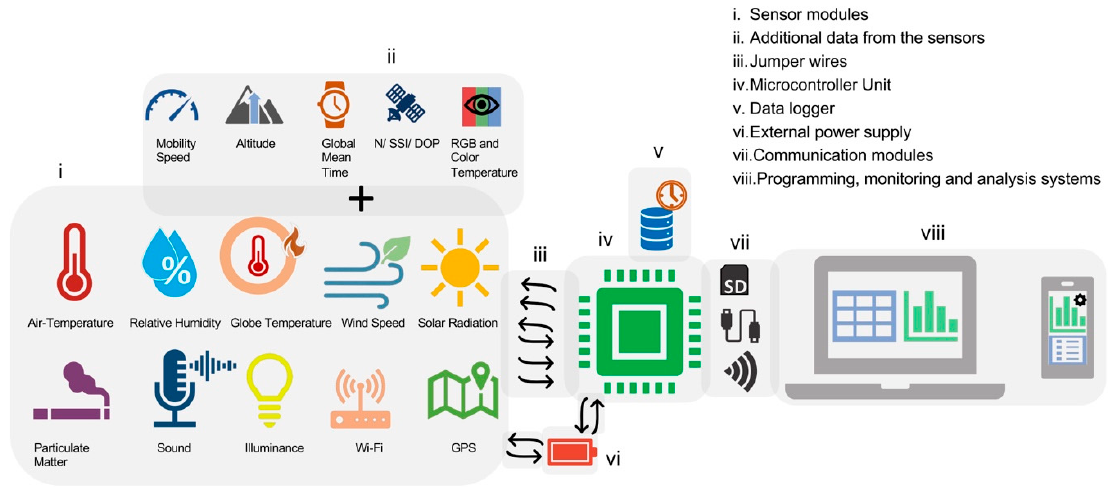
Figure 1. The schematic hardware connection of the model.